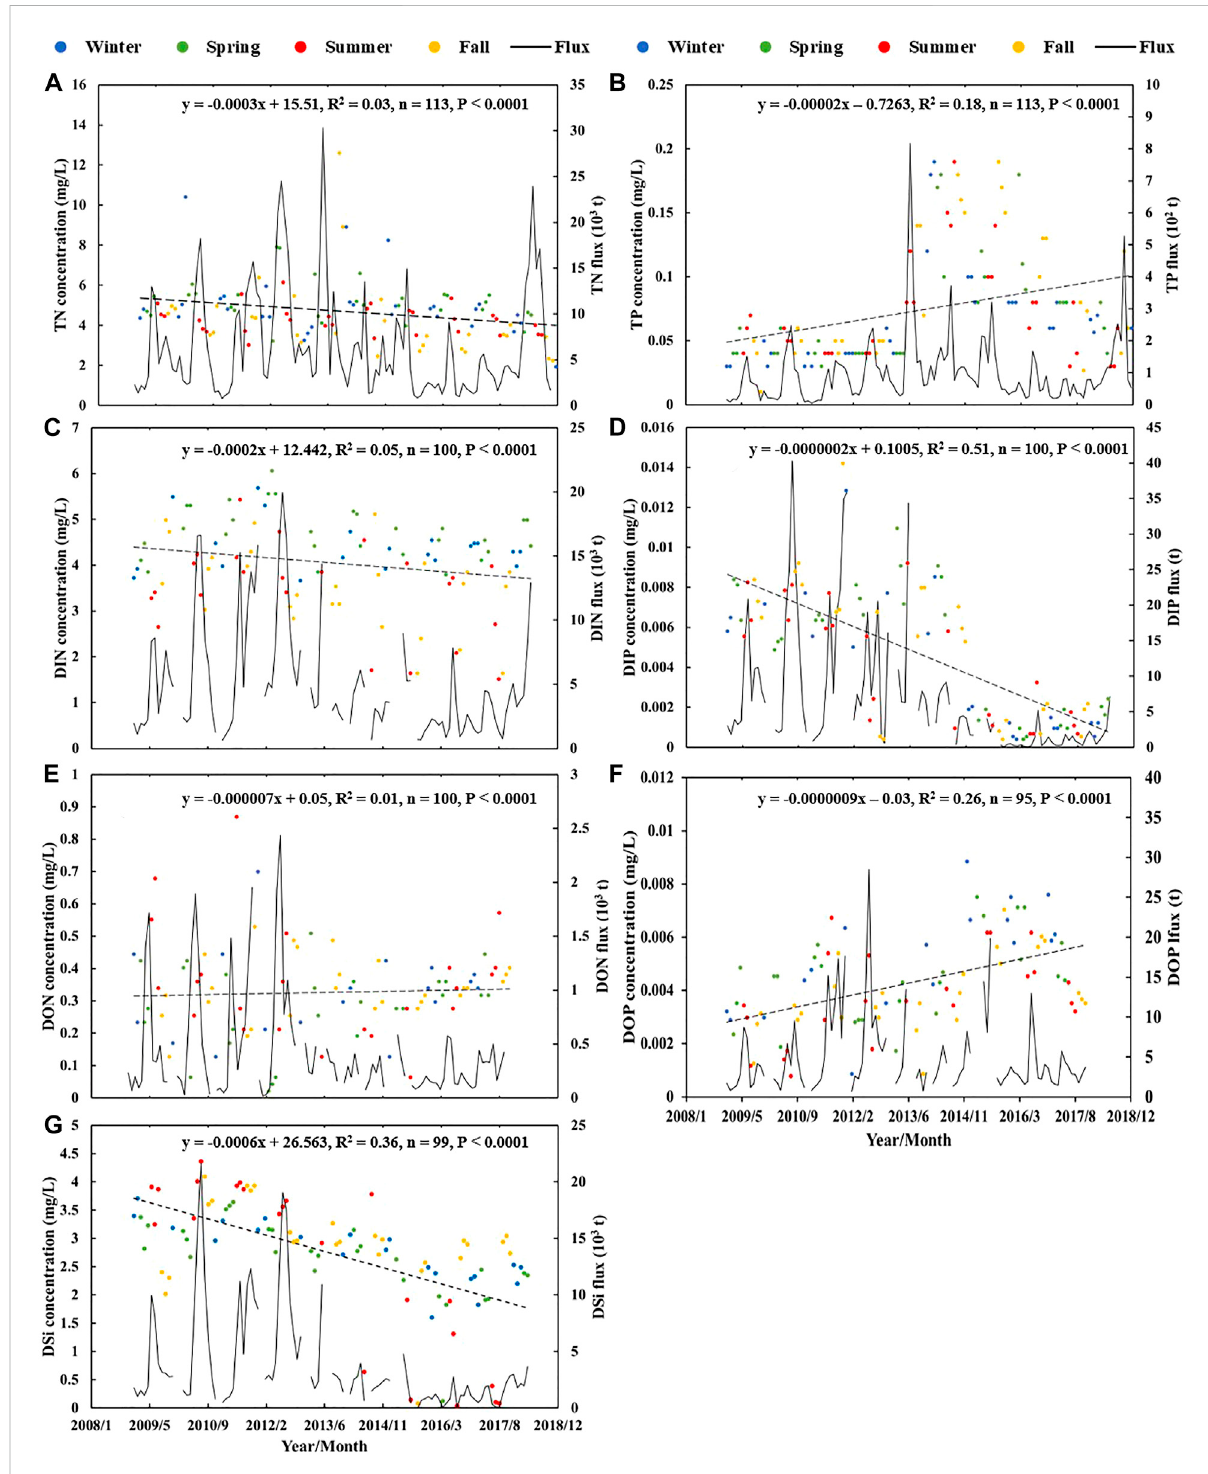
FIGURE 4 Monthly N concentrations and fl uxes (A,C,E) ; P concentrations and fl uxes (B,D,F) , and DSi concentrations (G) at the LJ station during 2009 – 2018. Winter: December to February; Spring: March to May; Summer: June to August; Fall: September to